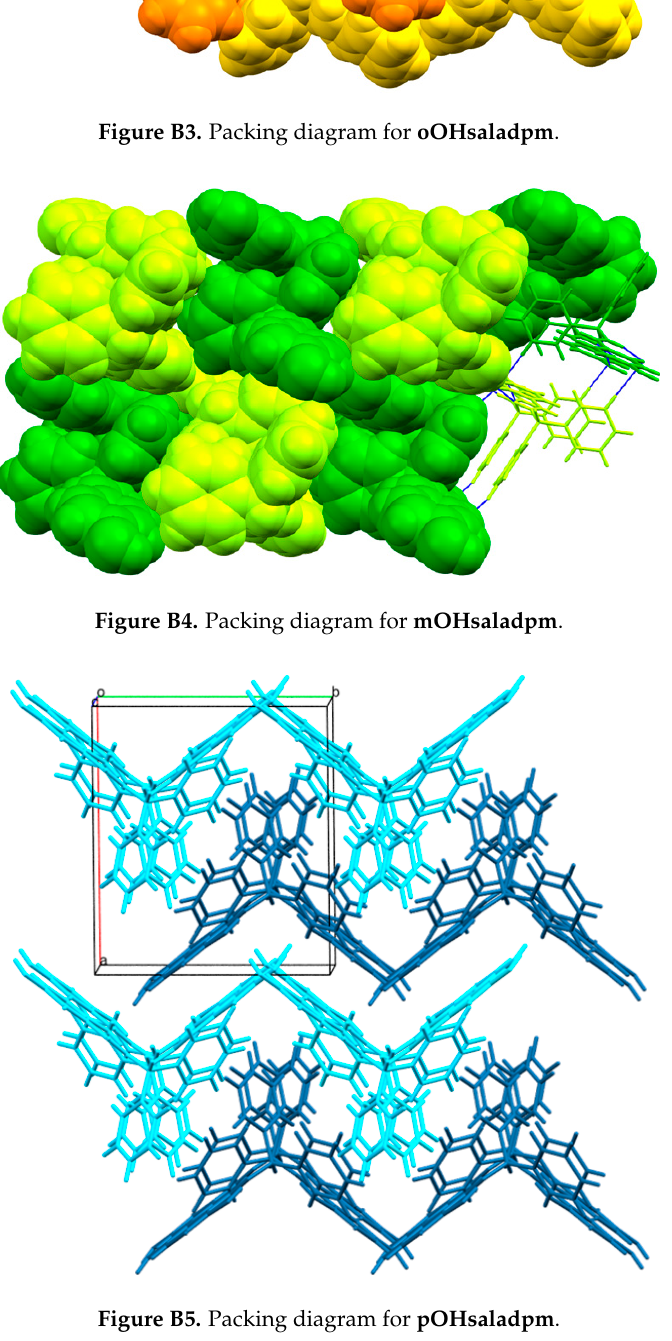
Figure B5. Packing diagram for pOHsaladpm .